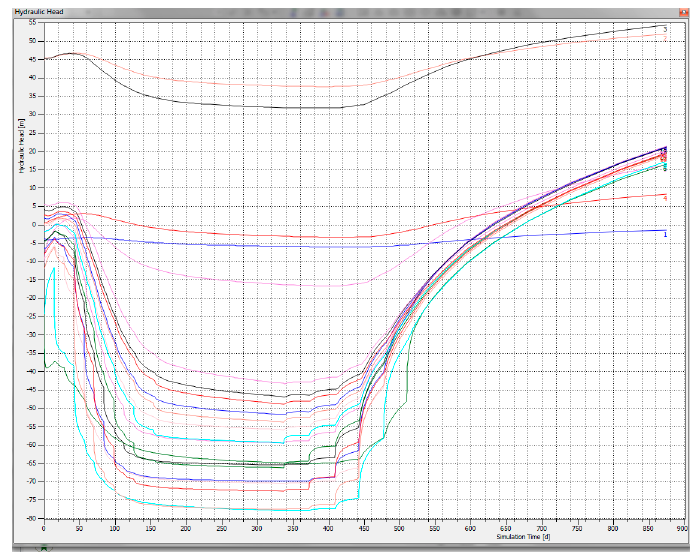
Figure 9. The predicted water drainage curves taking into account drive ‐ in filters positioned around the longwall (face) using FeFlow 6.1. Heads are in m.s.l.